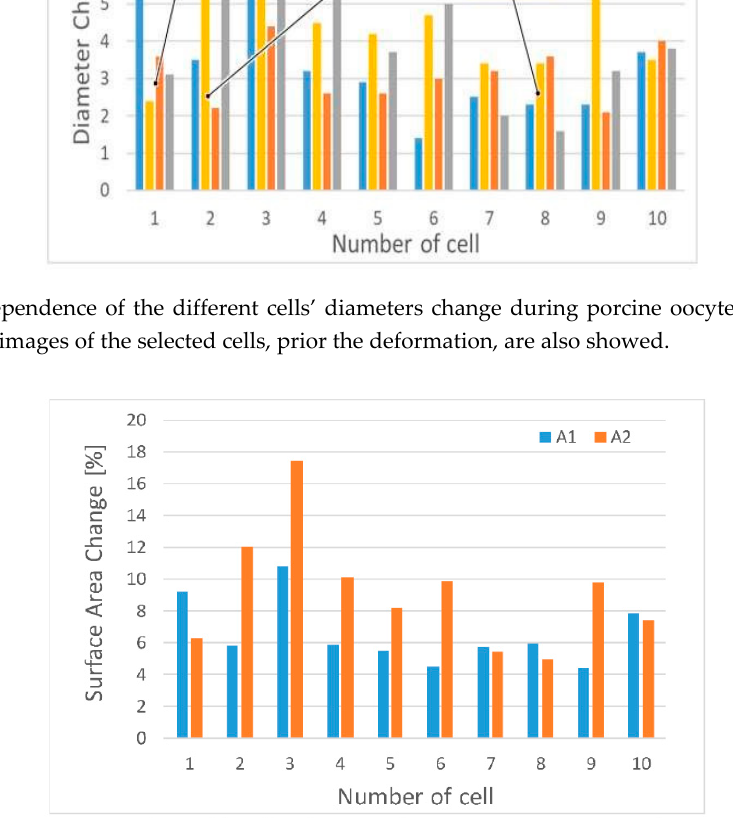
Figure 5. Dependence of the cell surface areas change during porcine oocyte